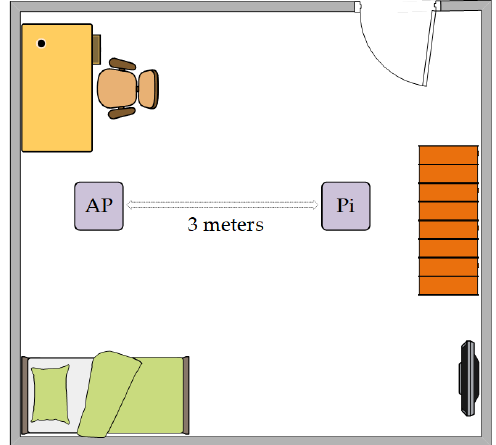
Figure 7. Experimental